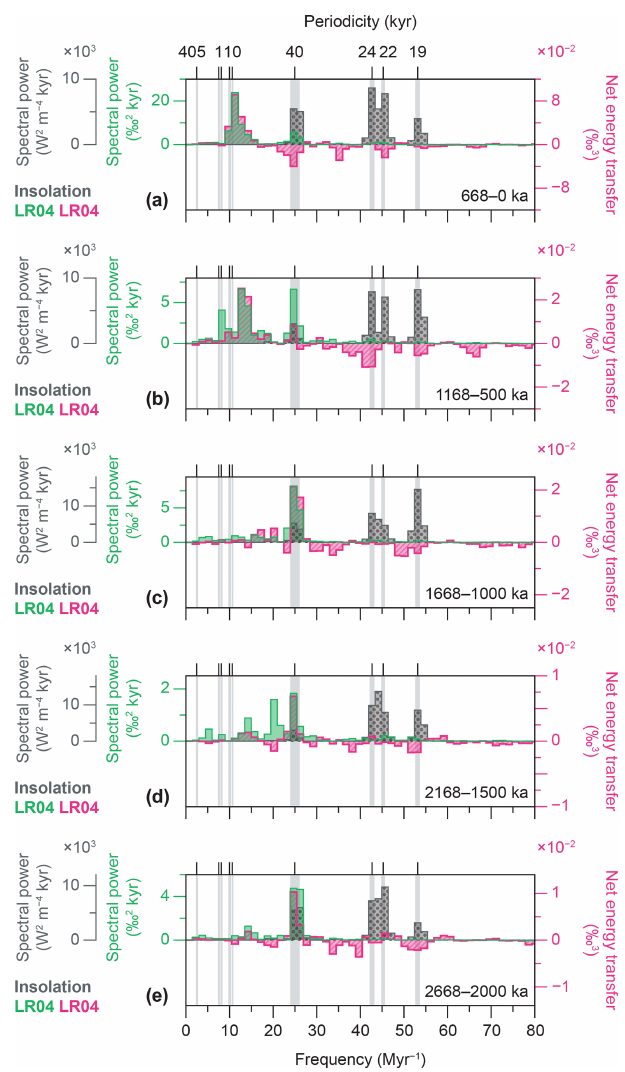
Figure 6. Qualitative linkage of power spectra of insolation to those of climate via energy exchanges among climate cycles: (a) 334ka, (b) 834ka, (c) 1334ka, (d) 1834ka, and (e) 2334ka. Computational settings are as in Fig. 5. Note that the scaling between the spectra and energy exchanges is arbitrary. Energy exchanges of the LR04 stack can be visually “scaled” (i.e. qualitatively compared) to the power spectrum of the LR04 by using multiplication factors of 430, 250, 360, 230, and 250 for panels (a) to (e) ,